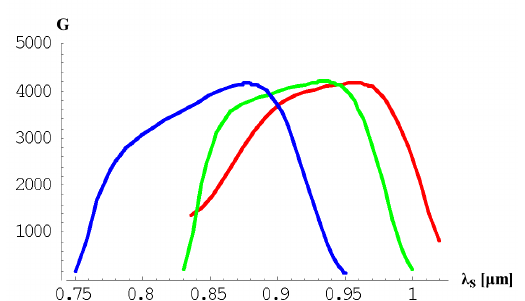
Figure 15. UBB NOPA in nonlinear crystals. Blue line, BBO crystal. Green line, DKDP crystal. Red line, LBO crystal.